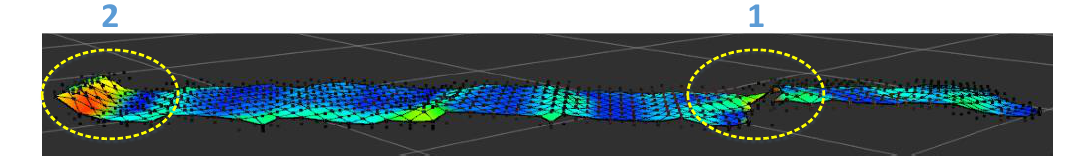
Figure 19. Experiment at different times.